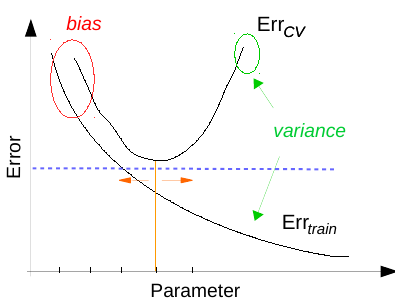
Figure 13. Tuning a learning algorithm.